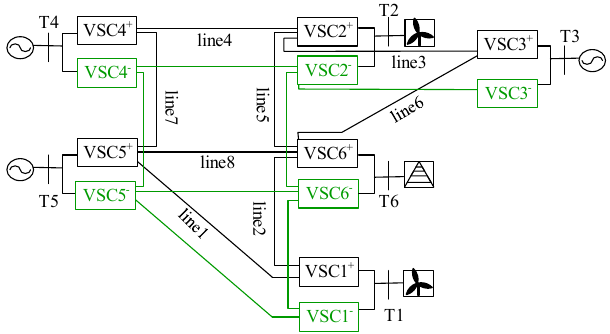
Figure 10. The topology of a 6-terminal bipolar VSC-MTDC.